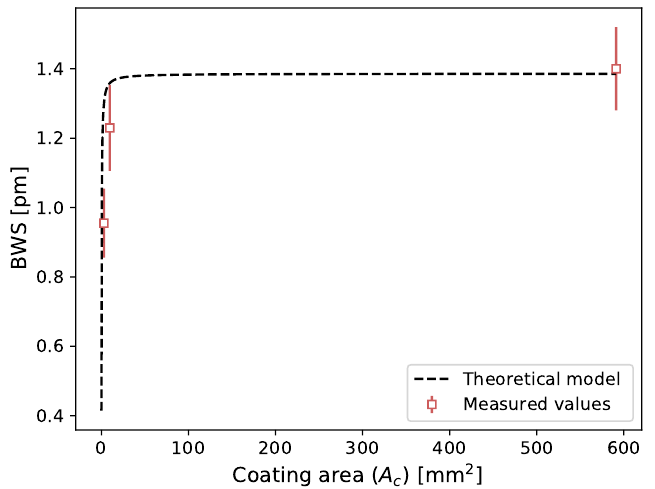
Figure 10. BWS in terms of coating area ( A c ) for theoretical model and measured values using a 20 Gy irradiation. The presented values correspond to the means and standard deviations of three measurements, except for the 591.25 mm 2 area (5.5 × 107.5 × 205 mm 3 PMMA plate) which corresponds to the means of 21